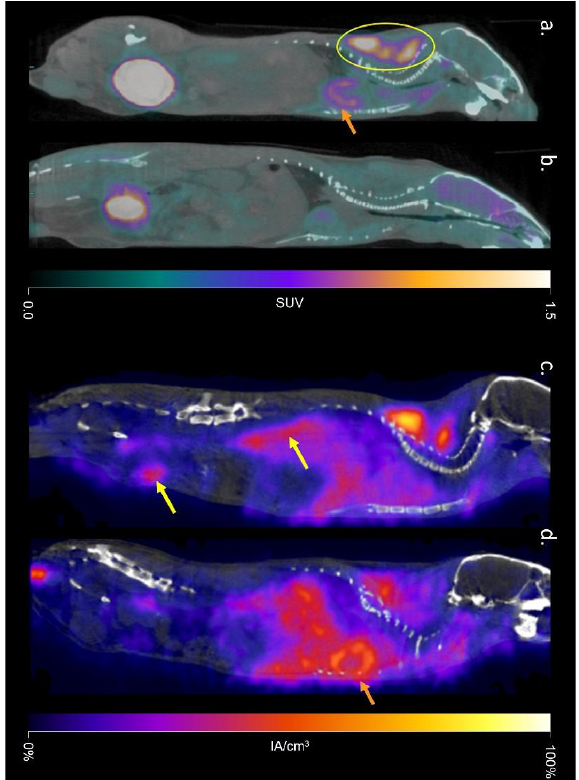
Figure 1. Representative sagittal 18 FDG-PET/CT of a CL-316,243 treated ( a ) and vehicle control ( b ) mouse and 125 I-BMIPP-SPECT/CT of a CL-316,243 ( c ) and vehicle ( d ) mouse ( n = 5). The classical interscapular fat pad is circled in image ( a ), cardiac uptake is indicated with orange arrows in ( a , d ), and prevertebral and anterior abdominal fat uptake indicated with yellow arrows in ( c ). Extensive hepatic, gastrointestinal, and mediastinal background uptake was seen with BMIPP but not